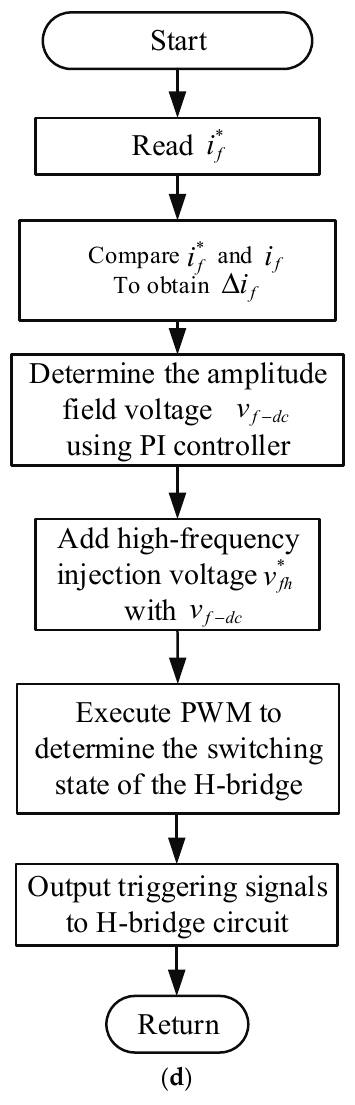
Figure 10. Digital signal processor (DSP) flowcharts. ( a ) Main program, ( b ) current loop interrupt service routine, ( c ) speed-loop interrupt service routine, and ( d ) H-bridge field current control.